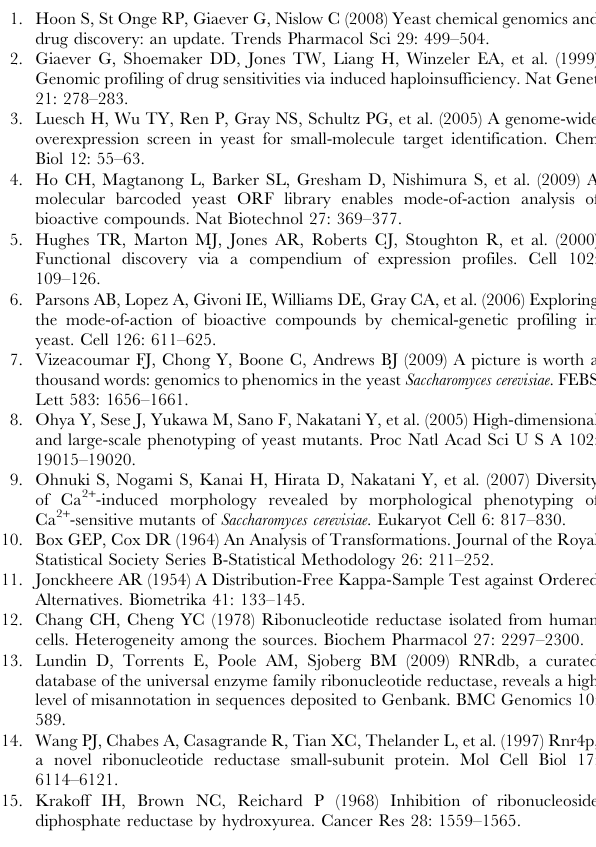
C) A list of parameters detected at stage C (budded cells with two nuclei). D) A list of parameters that represent various cell ratios. Table S8 A list of GO terms enriched in the top 100 genes ranked by the high-content image-based profiling for echinocan- din B treatment. Of the 4718 genes, 4379 genes were associated to at least one GO term, in which 84 of top 100 genes ranked by high-content image-profiling for echinocandin B were included. Using the GO term finder (see Materials and Methods), significant enrichment of 52 GO terms was detected at P , 0.05 with the Bonferroni correction (Corrected P-value column) among the 84 genes from 4379 genes, and GO terms associated with 100 and fewer genes in the 4379 genes (Number of annotations in the 4718 genes column) were